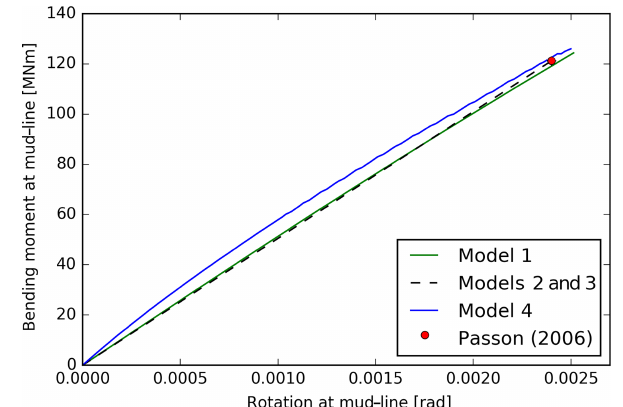
Figure 11. Rotational stiffness characteristics for the different mod- els.